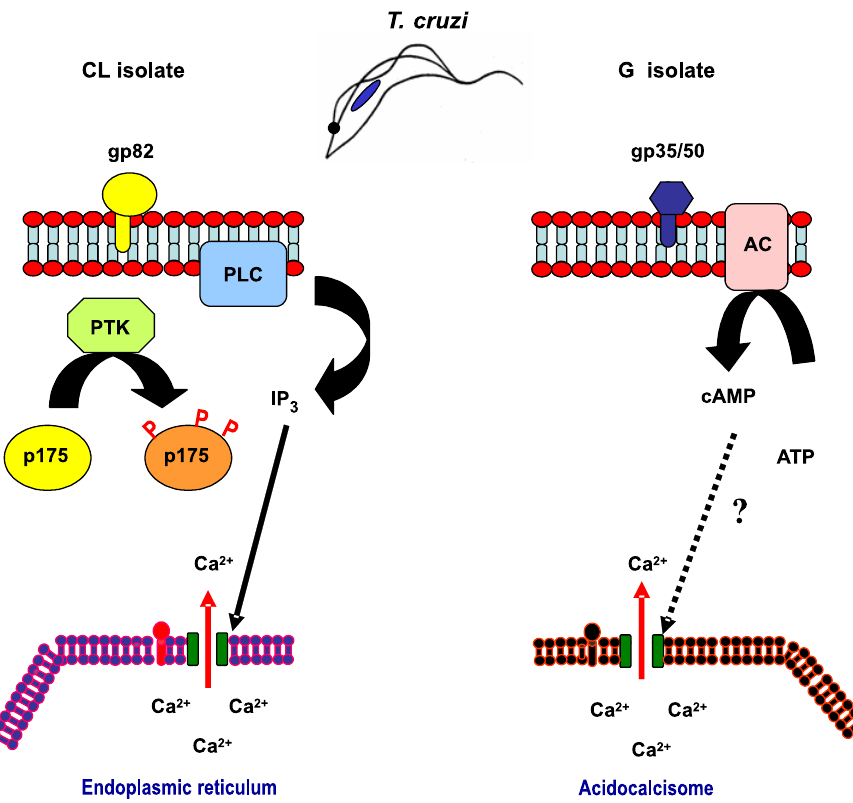
Fig. 5 – Activation of different signal transduction pathways in MT of phylogenetically distinct T. cruzi isolates during host cell invasion. In the highly invasive CL isolate, the recognition of the surface molecule gp82 by its receptor leads to PTK activation, phosphorylation of p175, activation of PLC and IP 3 generation, culminating with IP 3 -mediated Ca 2+ release from internal stores, probably endoplasmic reticulum. The components of the G isolate signaling cascade, triggered at the cell surface by gp35/50, are mostly unknown; cAMP generated by adenylyl cyclase may be involved, and acidocalcisomes appear to be the source of Ca 2+ required for parasite